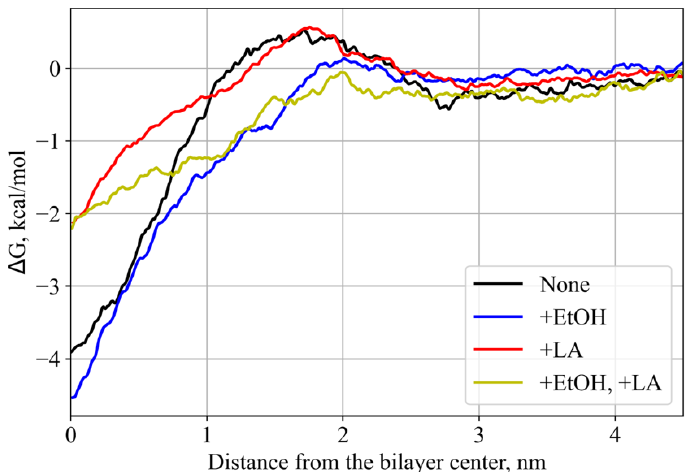
Figure 5. PMFs of lidocaine translocation across the SC membrane along the normal direction. ‘None’